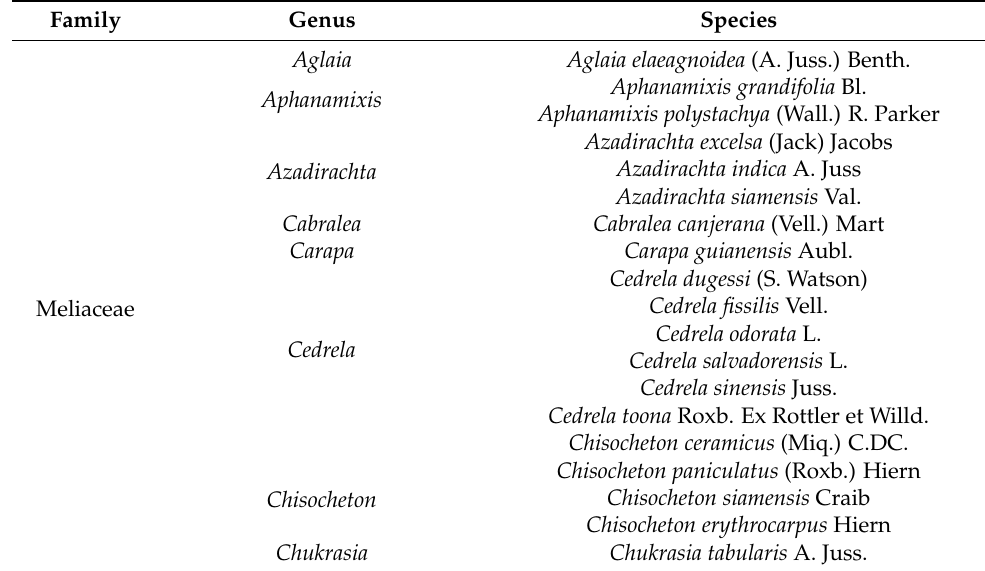
Table 1. The 19 insecticidal plant species of 8 genera in Meliaceae.